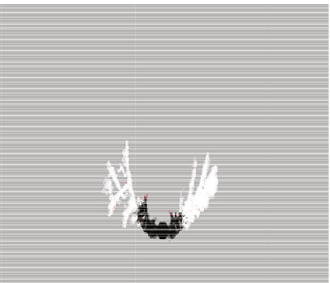
Figure 17: Two 350-mm holes